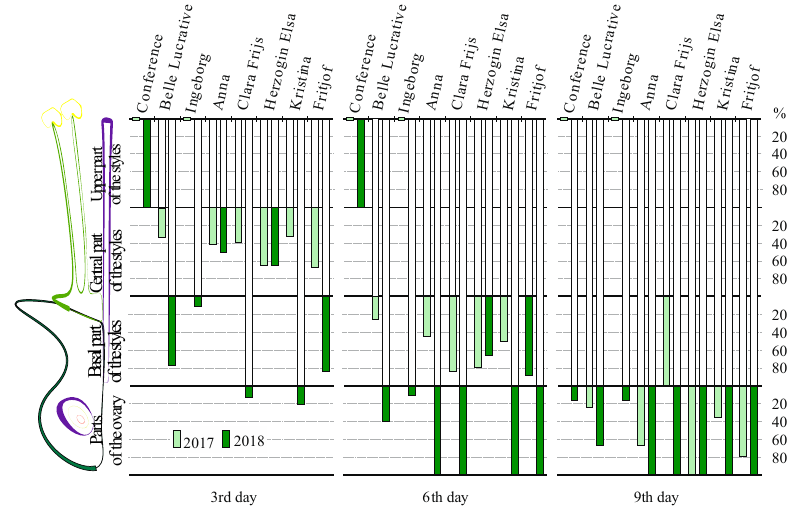
Figure 6. Dynamics of pollen tube growth through certain pistil parts (3, 6 and 9 DAP) of cultivar “Ingeborg” in different combinations of pollination in 2017 and 2018.